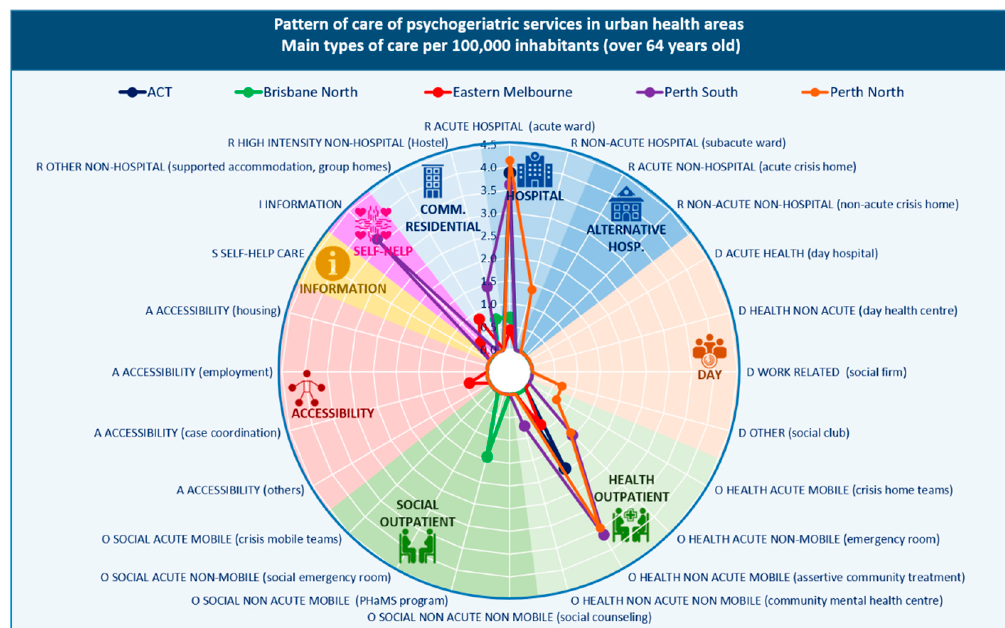
Figure 3. Pattern of care of mental health services in Australian Capital Territory, Brisbane, Melbourne, and Perth health districts: main types of care per 100,000 inhabitants aged 65 years and over.